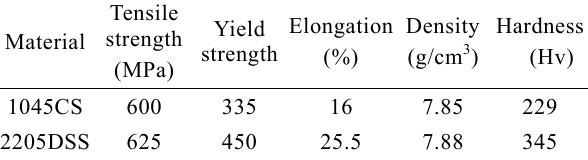
Table 2 Mechanical properties of AISI 1045 and AISI